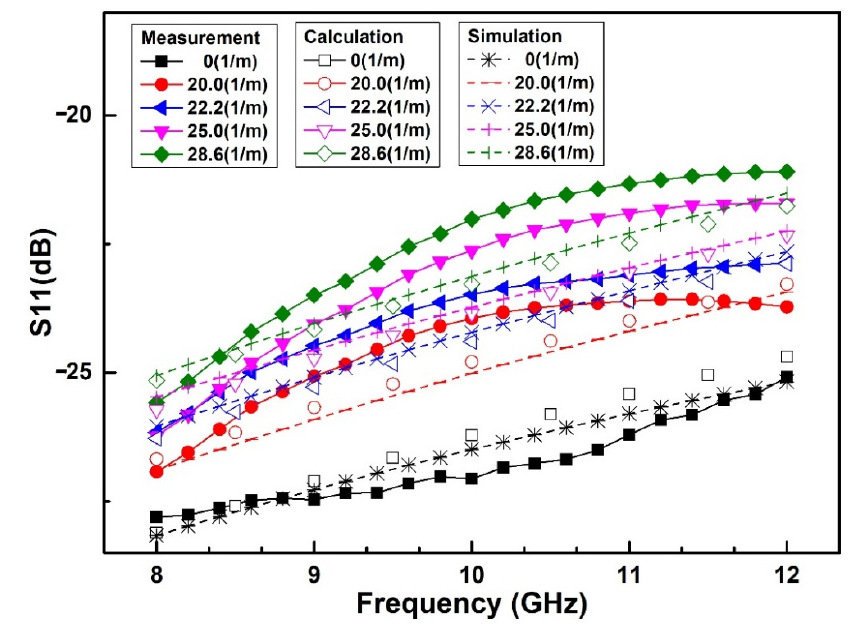
Figure 13. Measured reflection loss S 11 of the spring-like double-clamped beam switch with different substrate curvatures.